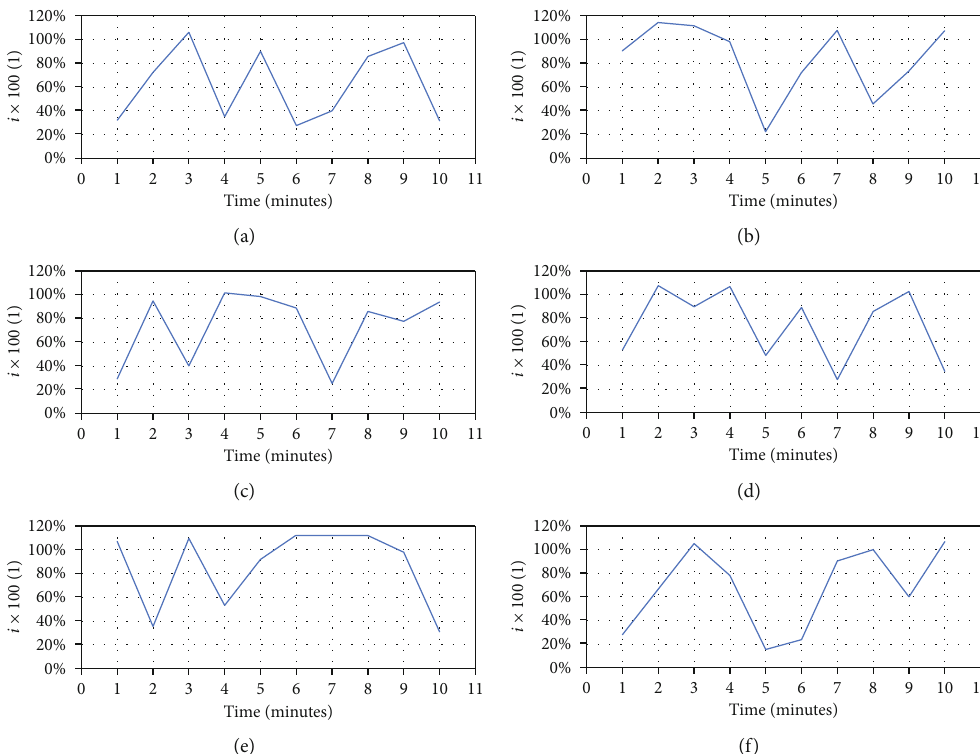
I I Figure 6: Normalized solar irradiance data, i , from the TGHI dataset over the 10 minutes per year with the highest RMS ramp n = n / STC rates. As one would expect for ramps caused by passing clouds, the changes in solar output can vary signi fi cantly from year to year. (a) 2016 (the year with the highest overall variability in the data), (b) 2014, (c) 2013, (d) 2012, (e) 2011, and (f) 2009. The three years not shown had similar waveforms to one of the above with 2008 comparable in shape to 2016, and both 2014 and 2015 are similar to